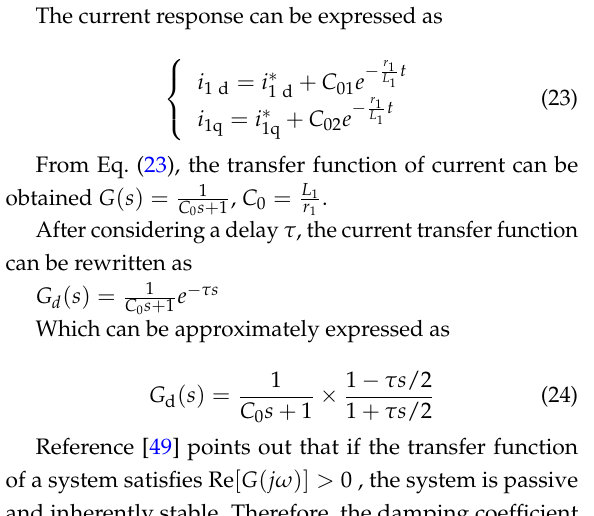
Fig. 6. Overall control block diagram of D-LCC mobile that x is the input signal of SOGI-QSG, and x α and x β is the output signal. According to Fig. 7, the transfer function of wireless charging system SOGI-QSG can be obtained. As shown in Eq.